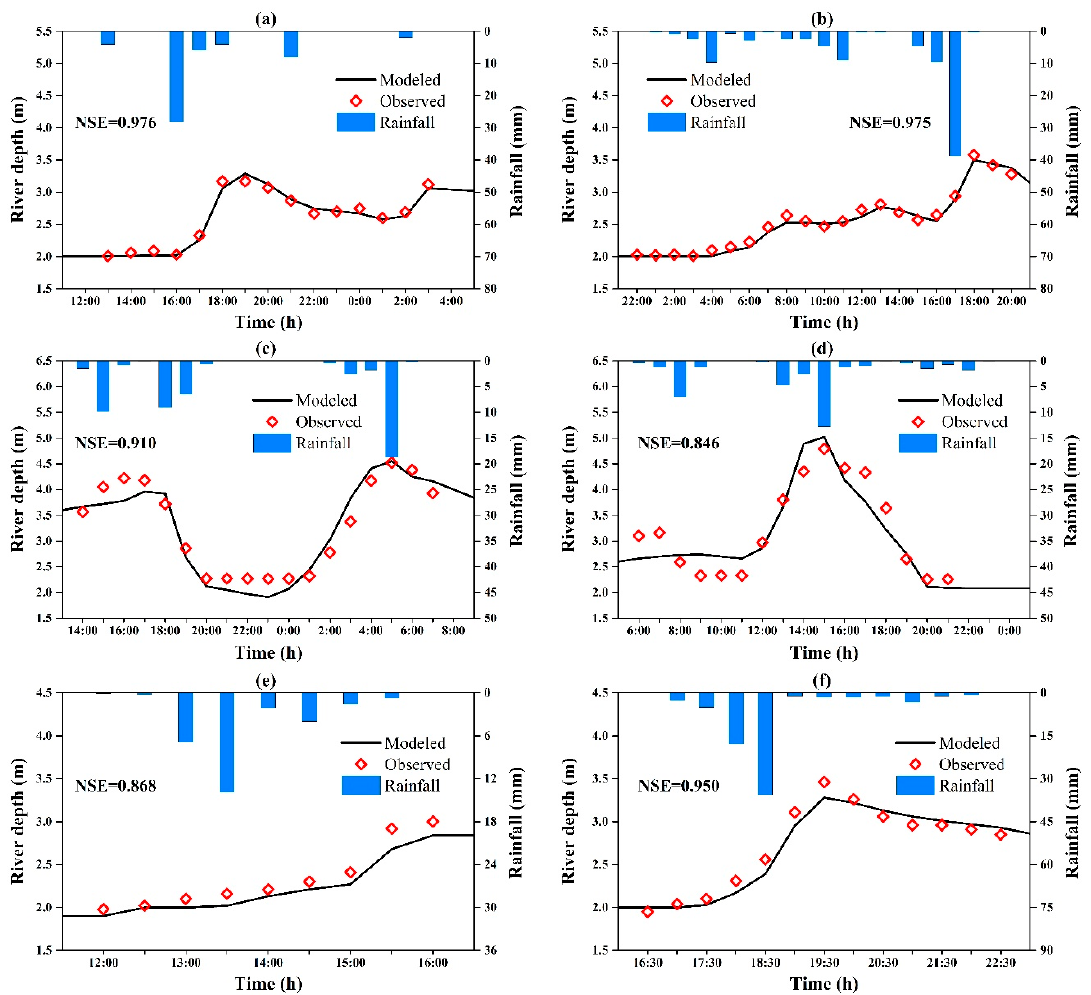
Figure 4. Modeled (black line) and observed (red diamonds) hydrographs at the outfall site for six rainfall events (blue bars) during the monitoring period: ( a ) rainfall event on 20 July 2019; ( b ) rainfall event on 24 August 2019; ( c ) rainfall event on 26 May 2019; ( d ) rainfall event on 24 June 2019; ( e ) rainfall event on 22 July 2019; ( f ) rainfall event on 17 August 2019.